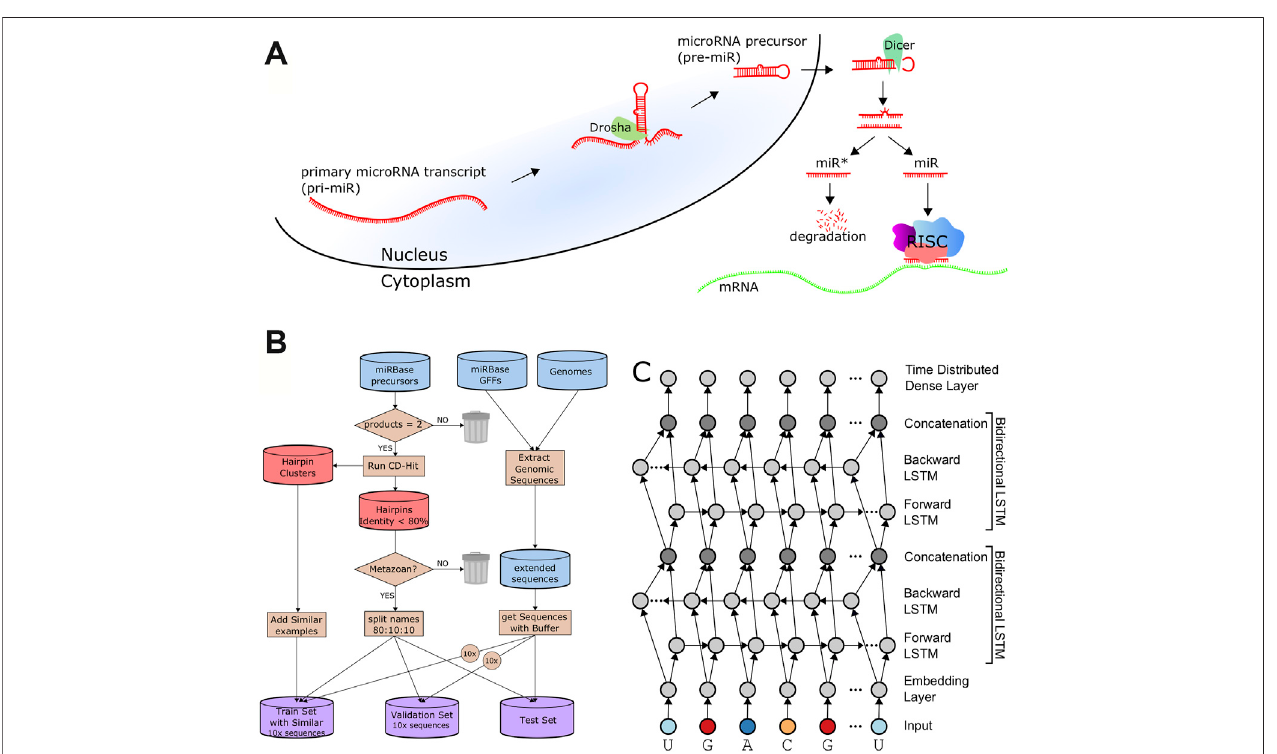
FIGURE 1 | Data Processing and Architecture. (A) . A schematic of microRNA biogenesis showing that two cleavages of double-stranded RNA results in four cut sitestoproducetwomatureproducts. (B) .Flowchartdescribingthegenerationofthetrain,validation,andtestsets. (C) .Thearchitecture ofDeepMirCutconsistsoftwo bidirectional LSTMs, and a time-distributed dense